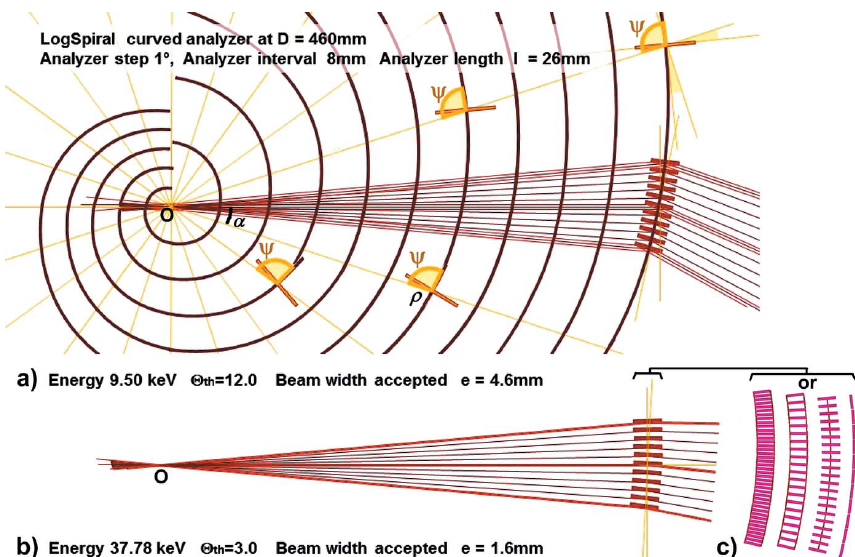
Figure 2 The positioning of several Si(111) analyser crystals on a logarithmic-spiral curve optimizes the paths of the beams coming from the centre O of this curve which impact with the same angle (cid:3) the middle of each analyser crystal; in this figure the crystals are tilted with a 1 (cid:3) pitch and the corresponding beam paths through this LogSpiral MAD filter are represented. ( a ) To avoid interception/cutting of beams coming from the sample, the maximum length of the crystals l and their spacing i are imposed by the lowest energy accepted by this rigid MAD system, here 9.5 keV, which corresponds to l = 26 mm and i = 8 mm for a sample-to-analyser distance D = 460 mm, and allow simultaneous measurements with an angular step of 1 (cid:3) and a beam width of 4.6 mm. ( b ) At higher energies, the same crystal size and spacing leads to a decrease in the width of the beams analysed to 1.6 mm at 37.78 keV. ( c ) This LogSpiral curved analyser surface can be realized either by a single thin curved crystal or by several crystals supported on a fixed and rigid dedicated curved